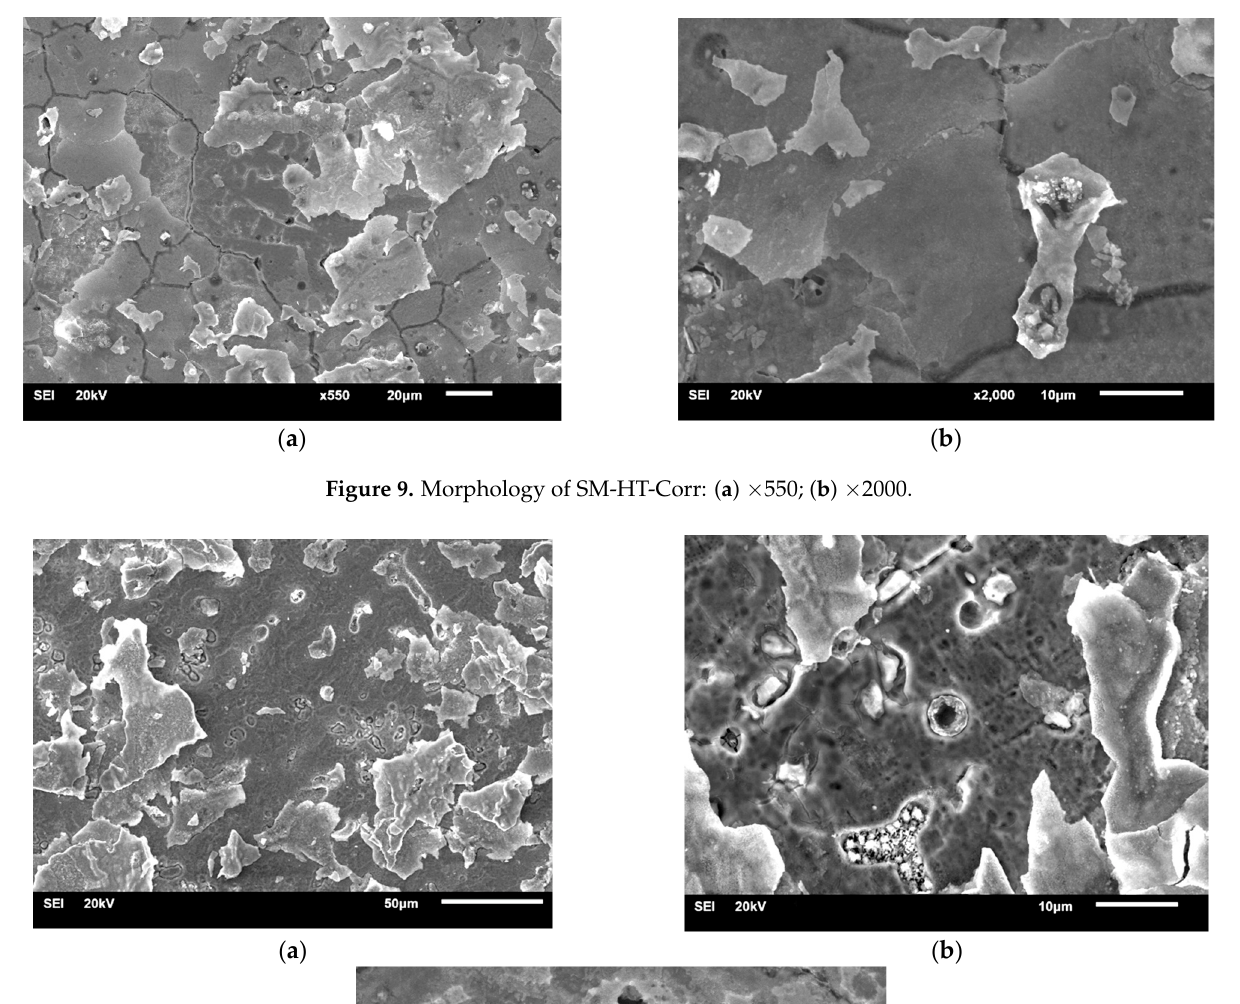
Table 4. Values of j corr and E corr from electrochemical examination.